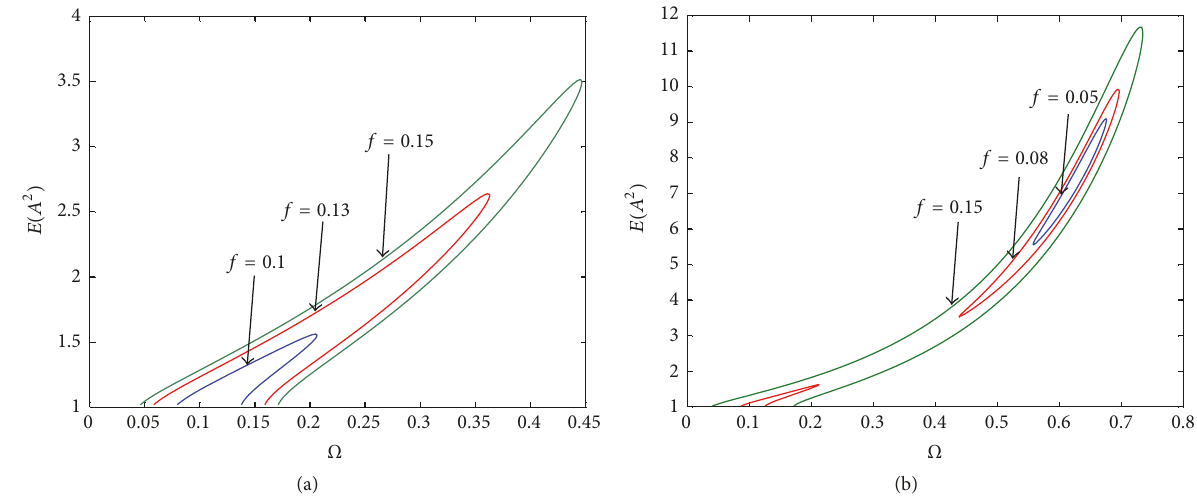
Figure 10: Mean-square responses under different external excitation amplitude 𝑓 for the noise intensity ̂𝛾 = 0.01 . (a) 𝜏 = 𝜋/2 ; (b) 𝜏 = 3𝜋/4